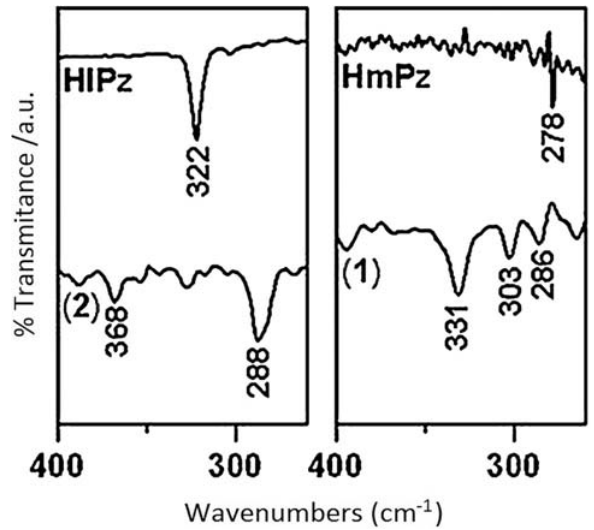
Figure 6. Far FT-IR spectra of the compounds HmPz, HIPz, 1 and 2